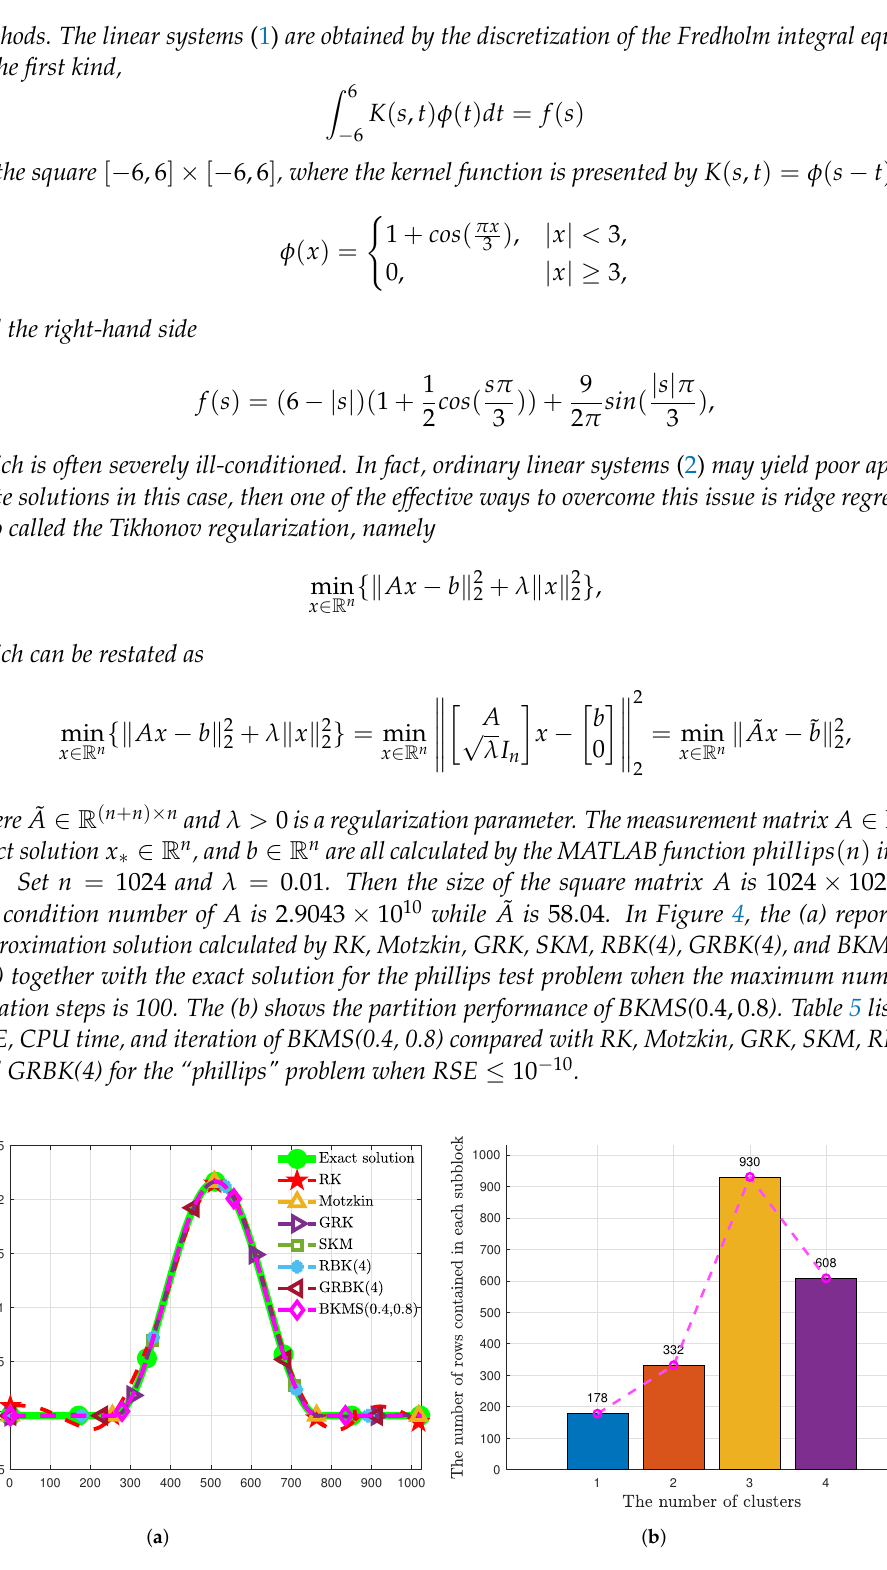
Figure 4. ( a ) The approximation solutions of all methods for the Phillips test problem compare with the exact solution. ( b ) The number of rows contained in each partition of